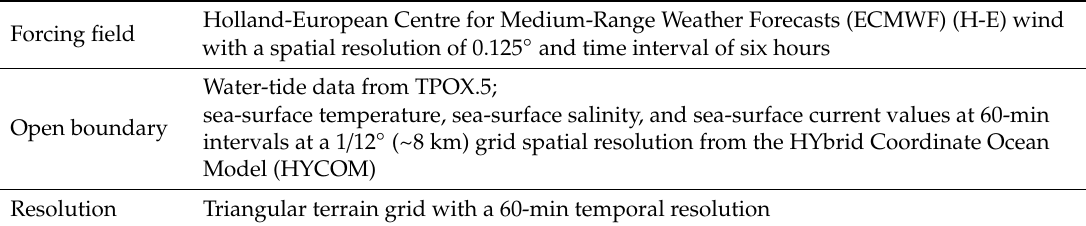
Table 1. Settings for the Finite-Volume Community Ocean Model (FVCOM).